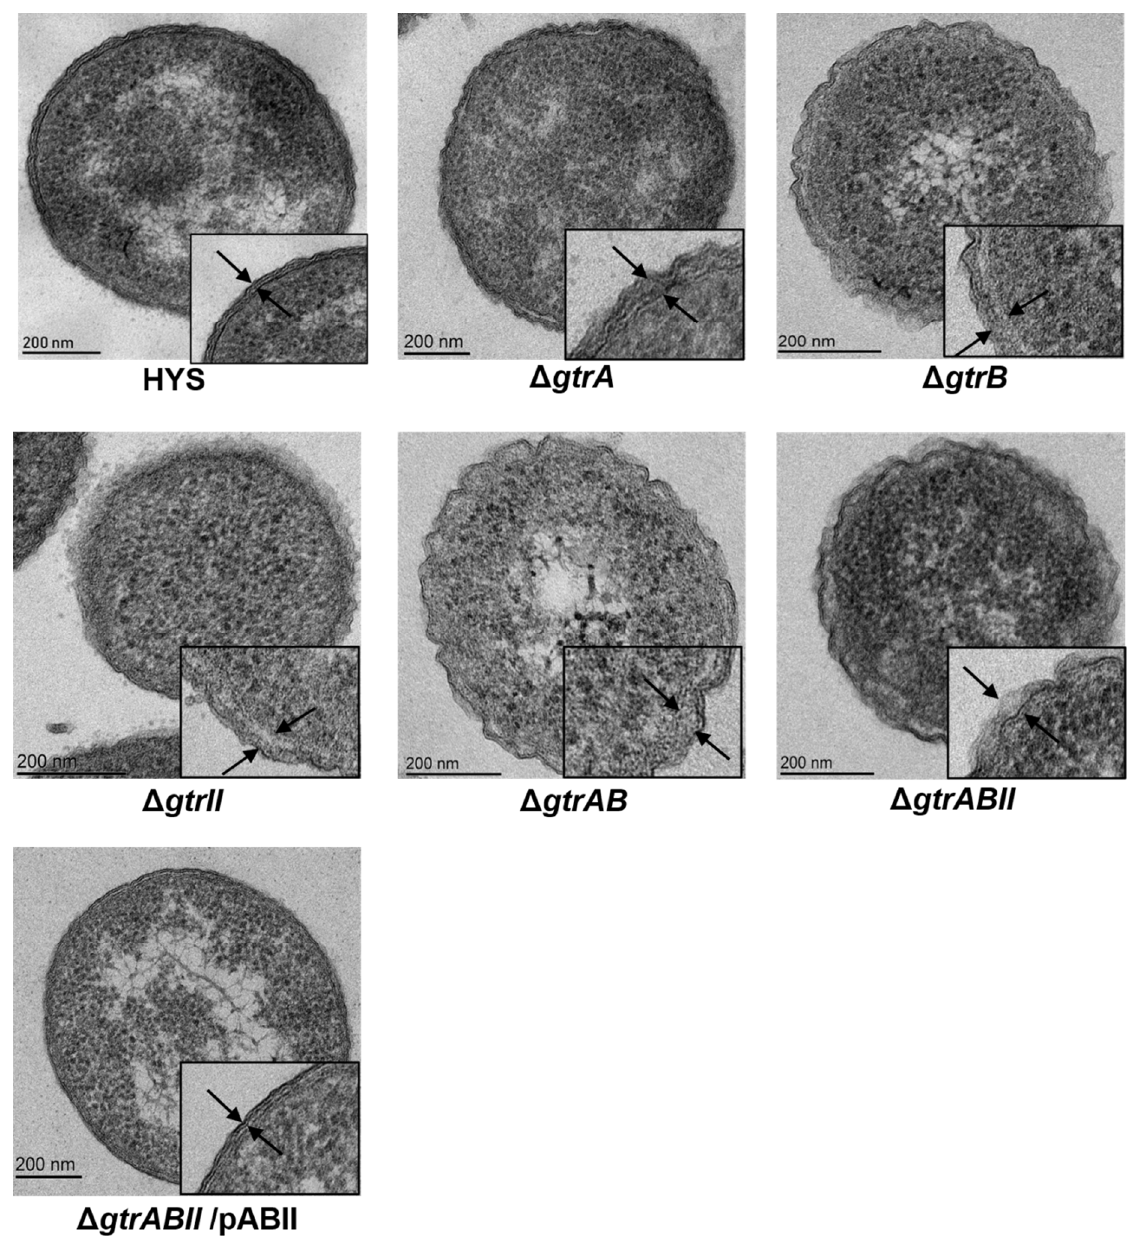
Figure 5. Surface topology of strains revealed by transmission electron microscopy after treatment with ruthenium red. The electron-dense material on the bacterial surface is indicated between the arrows. In ∆ gtrA , ∆ gtrB , ∆ gtrII , ∆ gtrAB and ∆ gtrABII , the surface material is less compact than HYS.